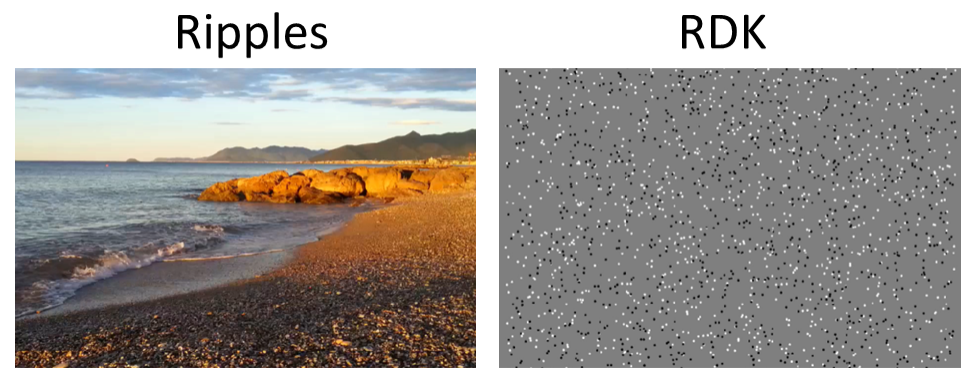
Figure 1. A snapshot of the dynamic visual stimuli used in this study. They were displayed with various sinusoidal speed modulations, which conferred to them a pulsating appearance. In the experiment, there was also a central fixation dot. RDK—random dot kinematogram.